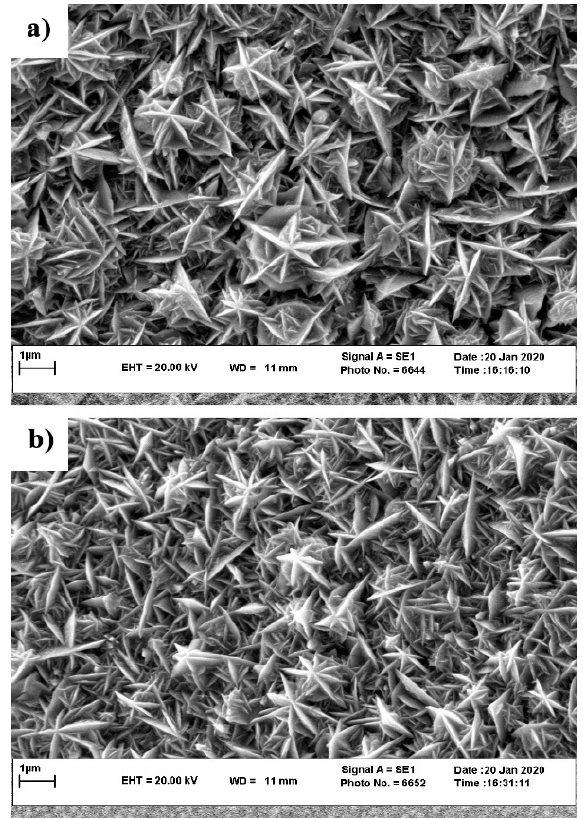
Figure 2. SEM surface morphology of the micro-/nanostructured Ni film on Samples ( a ) D12 and ( b ) D25.